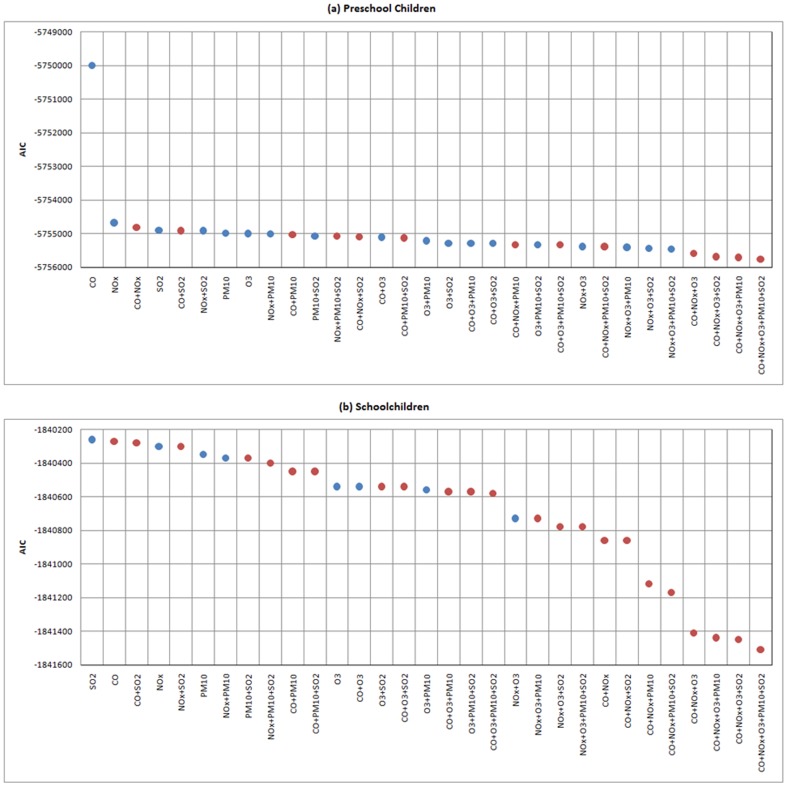
The model selection for (a) preschool children and (b) schoolchildren, where blue dots represent models with all significantly positive estimates for air pollutants, and red dots represent models with at least one non-significant or significantly negative estimate for air pollutants.Our final models were only considered among blue dots.